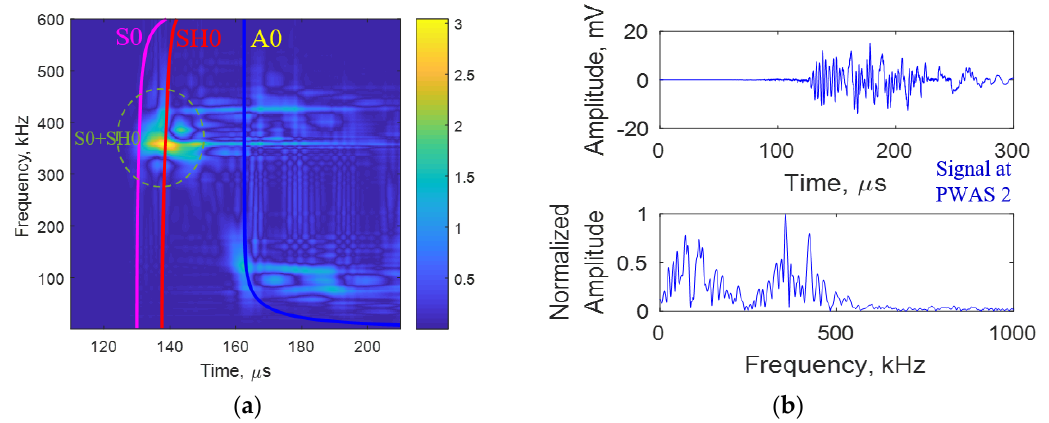
Figure 17. ( a ) Time-frequency plot from 16 J damage hit ( b ) Signal at PWAS 2 and the frequency spectrum due to 16 J damage hit.